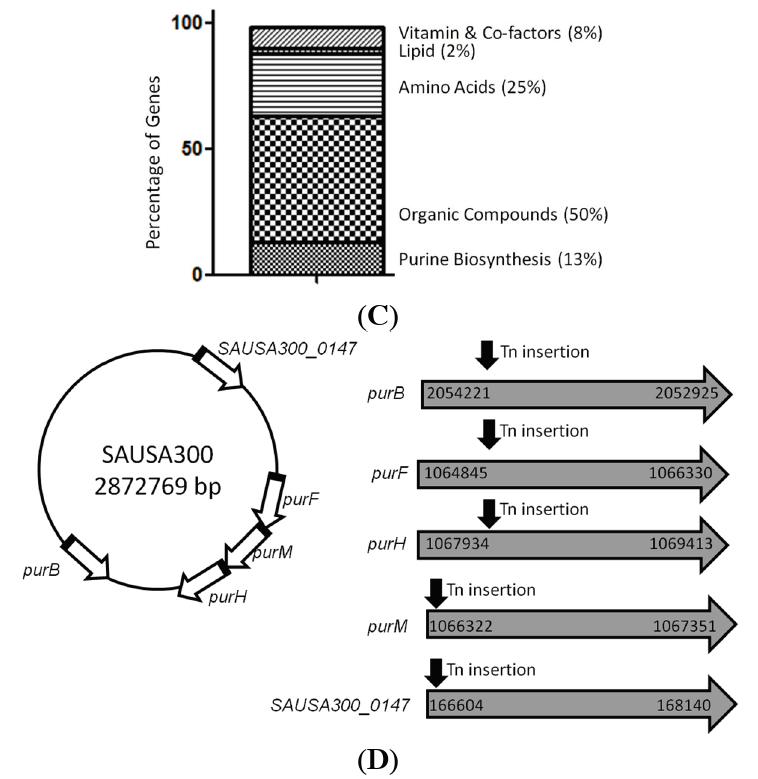
Figure 2. ( A ) Identification and characterization of the 124 genes involved in rifampicin persistence; ( B ) Pathways involved in rifampicin persistence; ( C ) Further breakdown of the metabolic pathways involved in persistence revealed a specific group of mutants belonging to purine biosynthesis; ( D ) The location of the transposon insertion in the genes involved in purine biosynthesis is depicted. All pathway analyses were performed using the Kyoto Encyclopedia of Genes and Genomes (KEGG) database, and the screen results were repeated and were